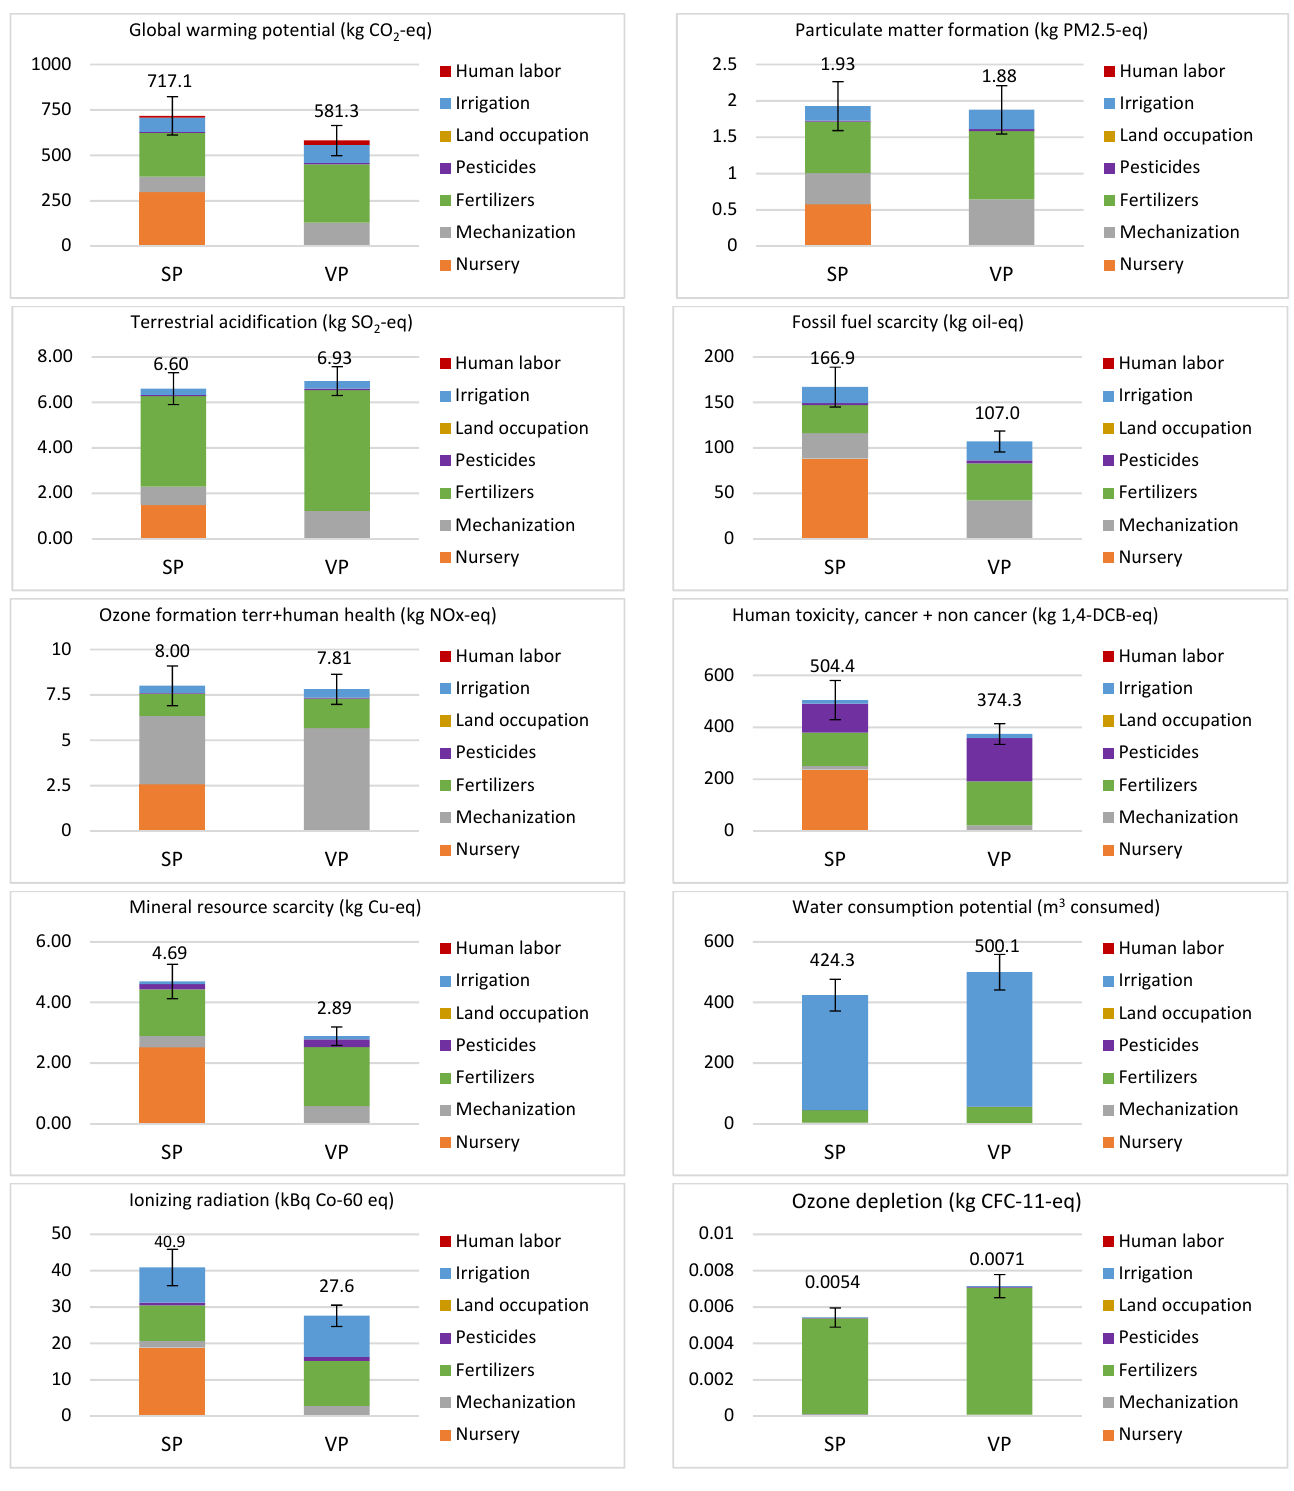
Figure 3. Cradle-to-farm gate ReCiPe 2016 midpoint impacts for 1 ton of seed propagated (SP) and vegetative propagated (VP) globe artichoke.